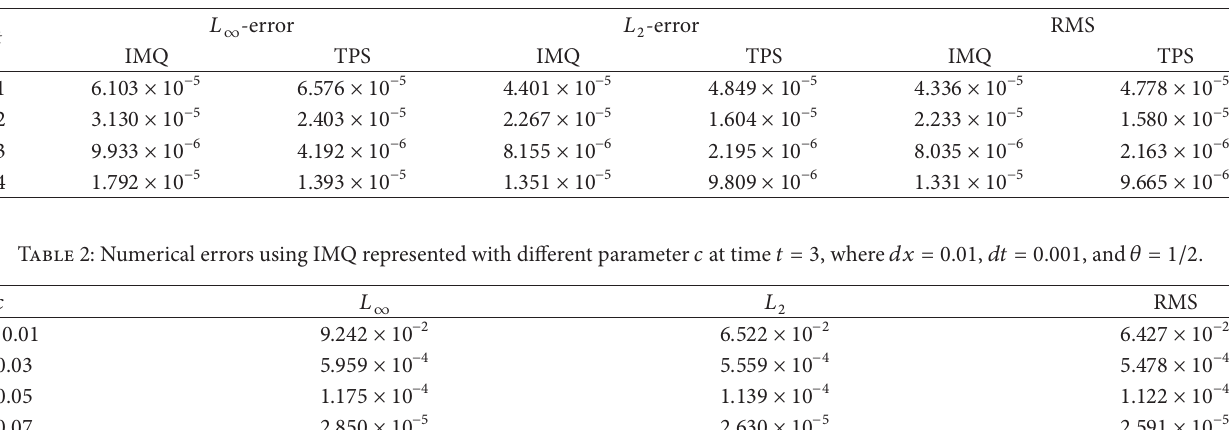
Table 1: Numerical errors using IMQ ( 𝑐 = 0.09 ) and TPS ( 𝑚 = 2 ) represented at different times, where 𝑑𝑥 = 0.01 , 𝑑𝑡 = 0.001 , and 𝜃 = 1/2 .